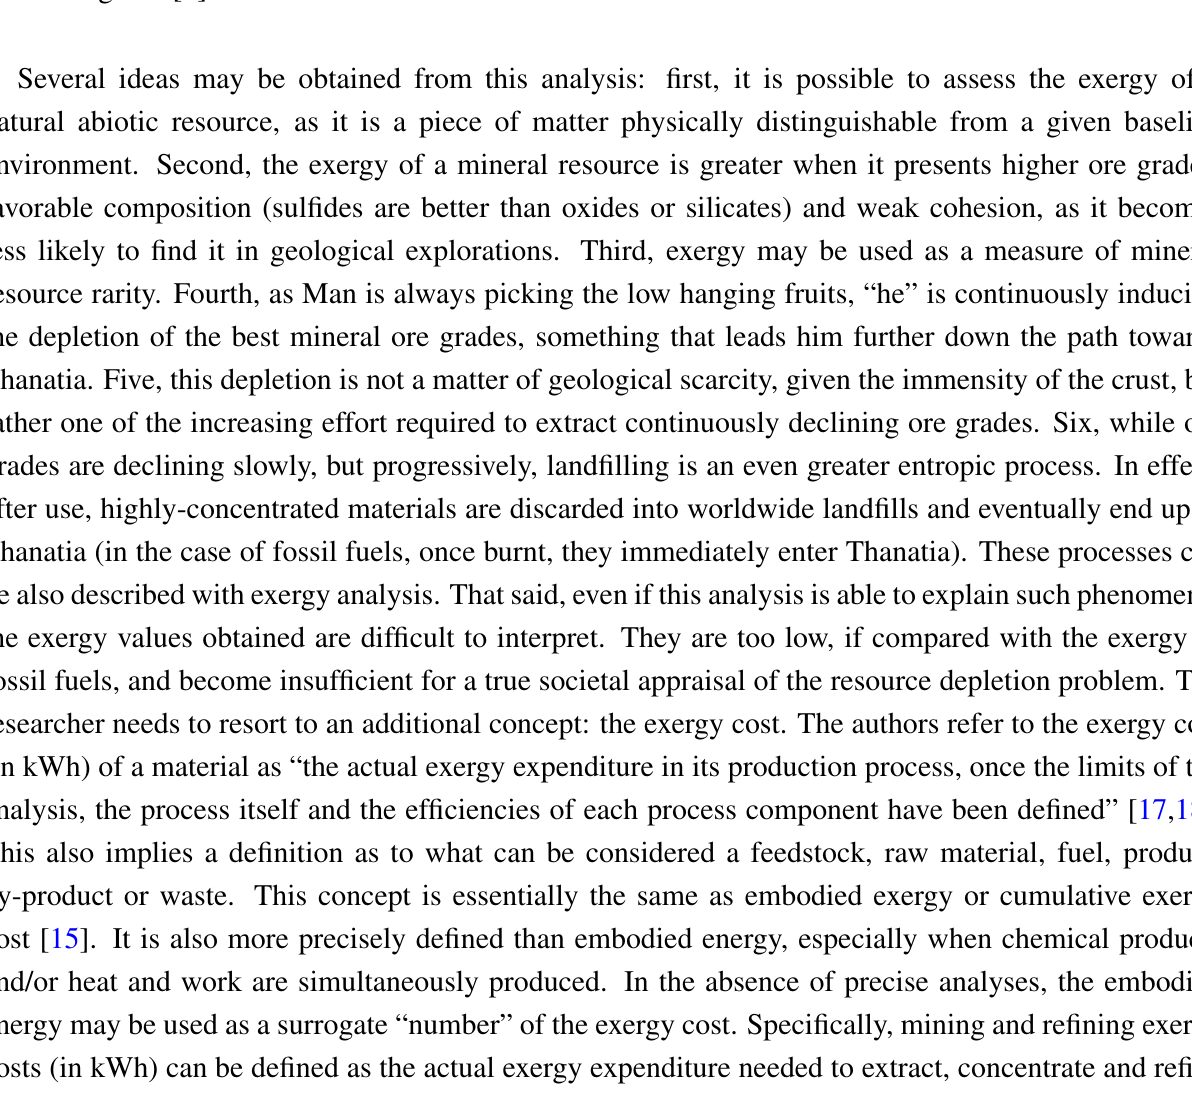
Figure 2. The exergy and exergy cost needed to extract a mineral as a function of the ore grade